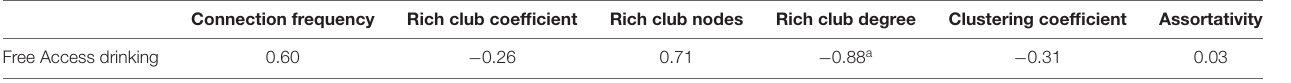
TABLE 3 | Correlations between Baseline network metrics and Free-Access drinking levels.